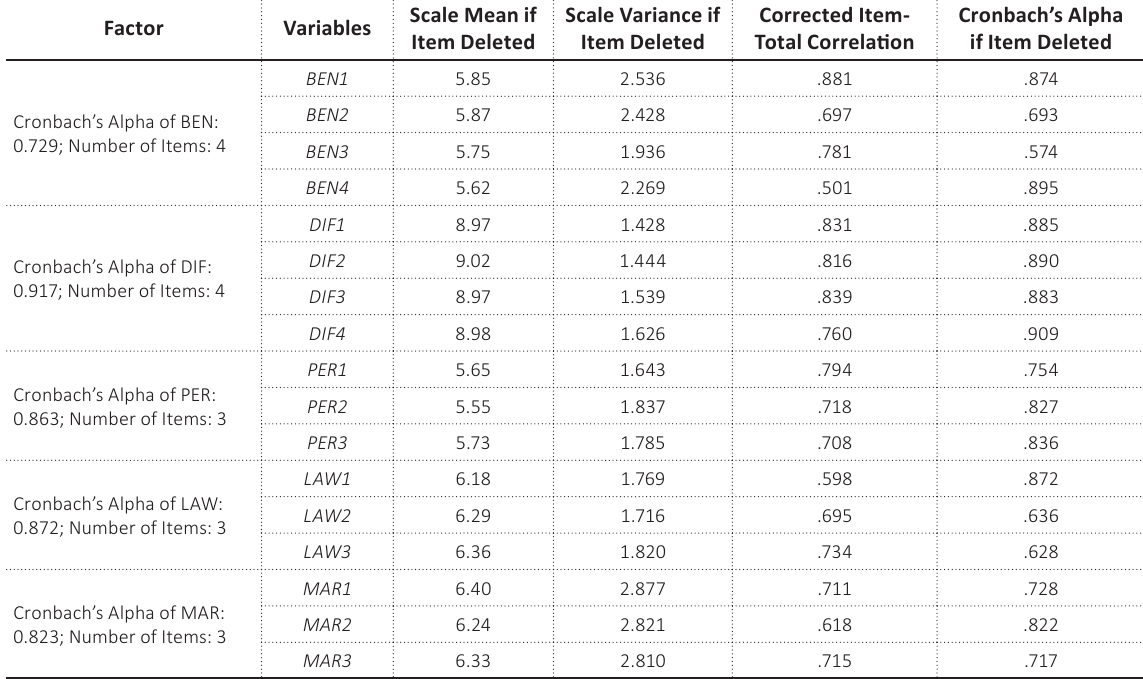
Table A3. Item-total